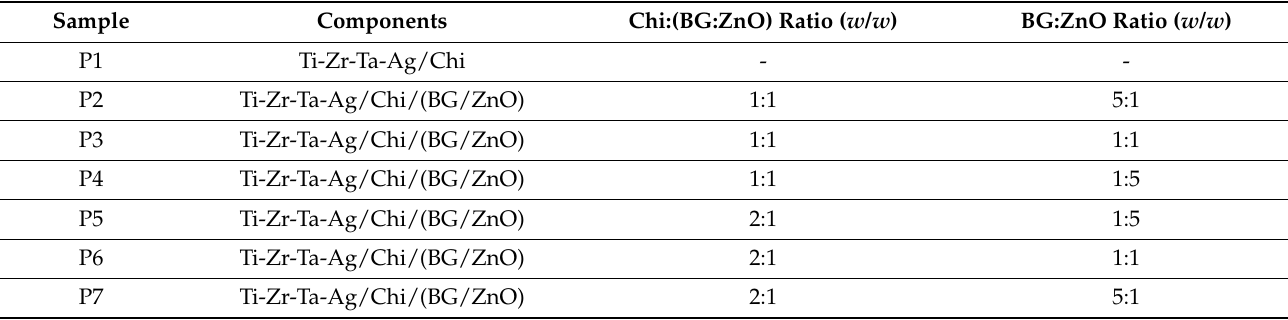
Table 1. List of fabricated samples and components.